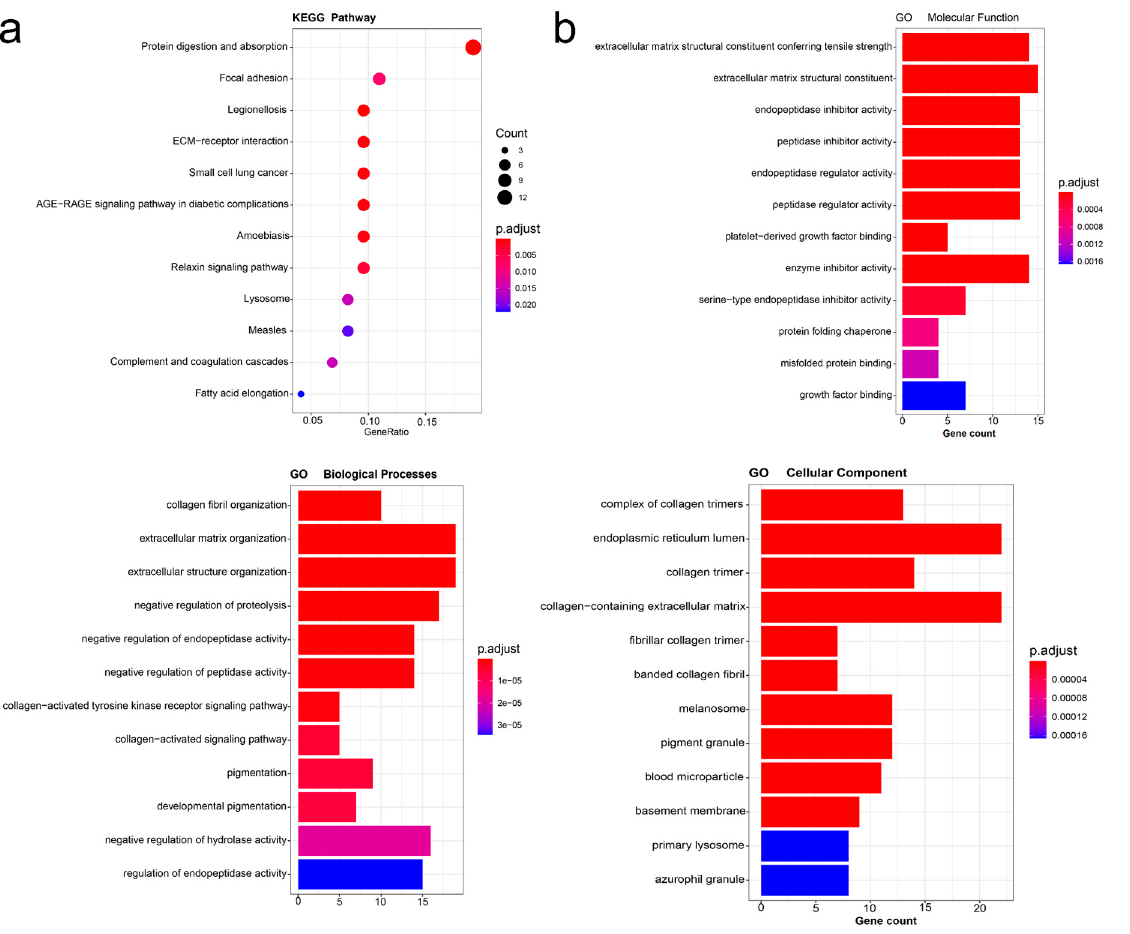
Figure 7. The enrichment analysis of PLOD3 and most frequent neighboring genes. ( a ) KEGG pathway analysis was obtained according to PLOD3-binding and interacted genes; ( b ) Bar plot of GO enrichment in cellular component terms, biological process terms, and molecular function terms.